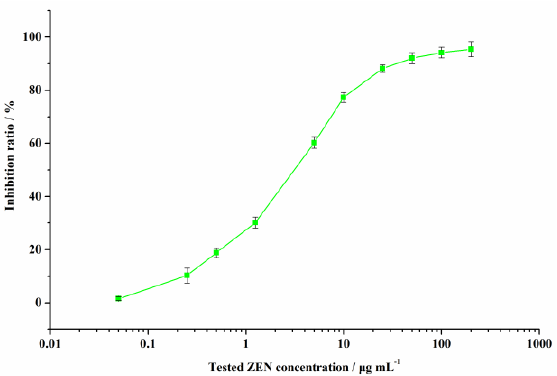
Figure 5. Standard curve for ZEN contaminant detection using the developed QCM immunochip.